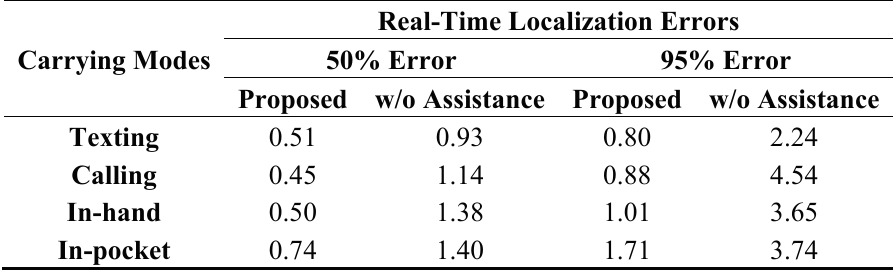
Table 2. Localization error from the proposed method and the method without vector graph assistance with four carrying modes (Unit: